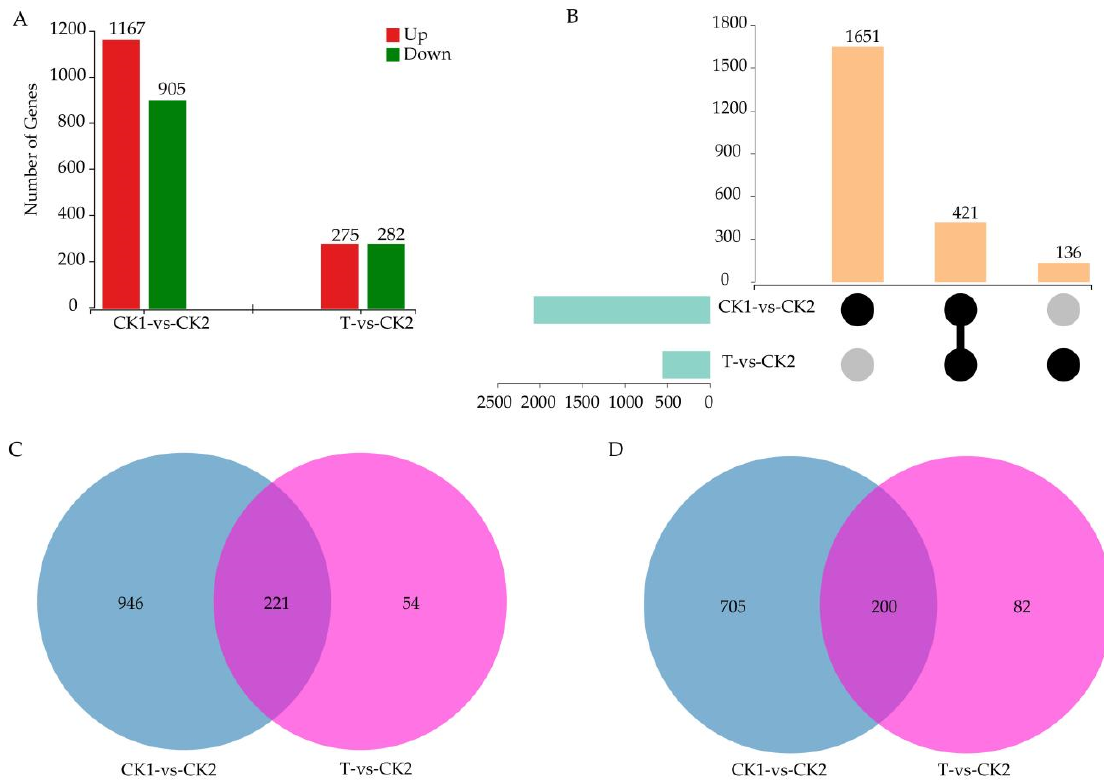
8 of 27 Figure 1. The effect of trehalose treatment on the growth of watermelon seedlings under 150 mM NaCl stress. ( A ) Phenotype of watermelon seedlings in Hoagland solution under trehalose and NaCl treatment for 1 week. Scale bar = 5 cm. ( B ) Measurements of the stem diameter, ( C ) biomass, and ( D ) plant height of seedlings. ( E ) MDA content, ( F ) POD activity, ( G ) SOD activity, ( H ) CAT activity, and ( I ) K + /Na + ratio of roots. Error bars indicate SE (n = 3). Small letters indicate significant differences among the different treatments ( p < 0.05). CK1 represents watermelon seedlings cul ‐ tured in normal Hoagland solution; CK2 represents watermelon seedlings cultured in Hoagland solution containing 150 mM NaCl; 5 mM, 10 mM, 20 mM and 30 mM represent watermelon seed ‐ lings cultured in Hoagland solution containing 150 mM NaCl and indicated concentrations of tre ‐ halose. 3.2. RNA ‐ seq Analysis after Trehalose Treatment to Watermelon seedlings under Salt Stress To explore the molecular mechanism underlying the improvement in salt tolerance of watermelon by exogenous trehalose, RNA sequencing was performed using the roots of watermelon seedlings, with three biological replicates for each group (a total of nine samples). After data filtering, each sample produced 6.46 Gb data on average. The data quality Q30 was greater than 94.28%; the average genome alignment rate was 92.11%,